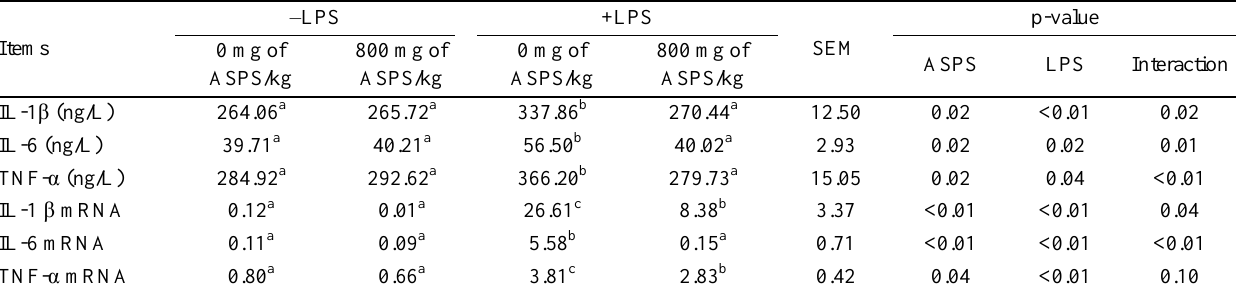
Table 4. Effects of dietary ASPS supplementation on plasma concentration of pro-inflammatory cytokines and its relative mRNA level in spleen of weaned piglets challenged with LPS 1